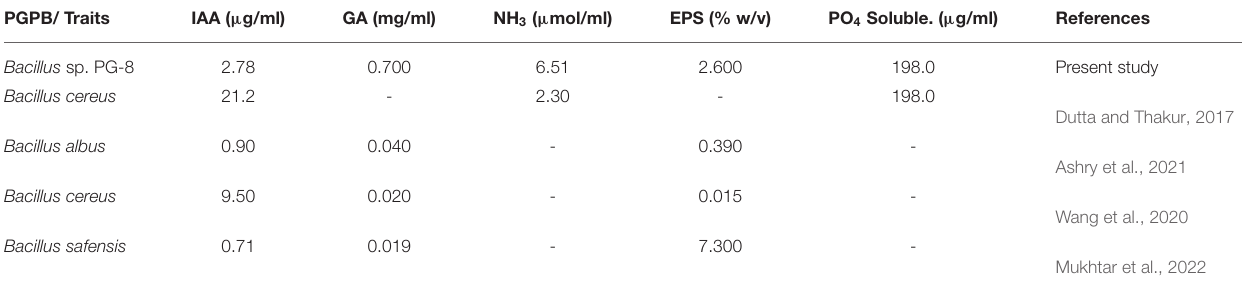
TABLE 3 | Plant growth-promoting traits of Bacillus sp. PG-8 with other Bacillus species. PGPB/ Traits